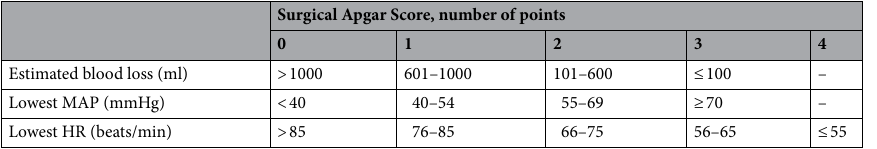
Table 1. Calculation of the surgical Apgar score, ranging from 0 to 10 points, with lower scores associated with worse postoperative outcomes. MAP mean arterial pressure, HR heart